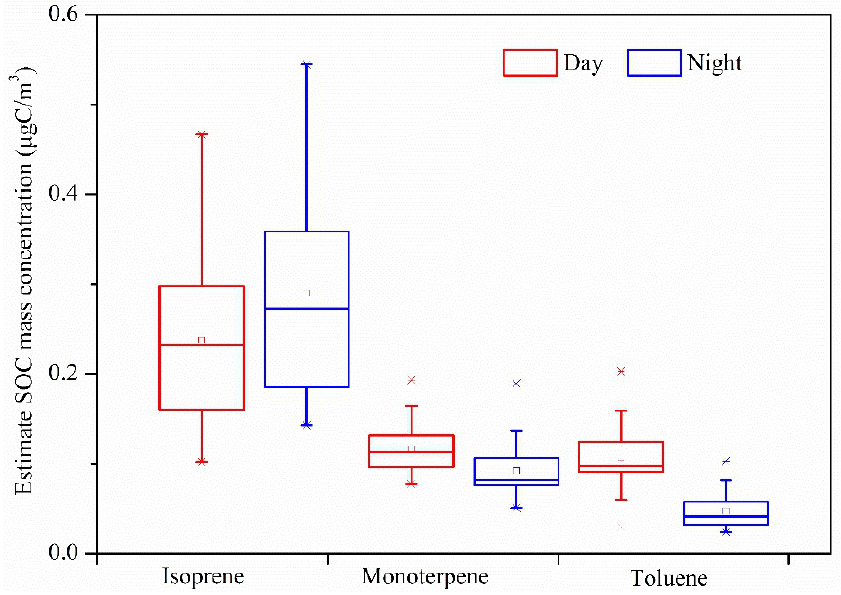
Figure 6. Estimate SOC mass concentration by day and by night in the rural area of Guanzhong Plain, Northwest China.